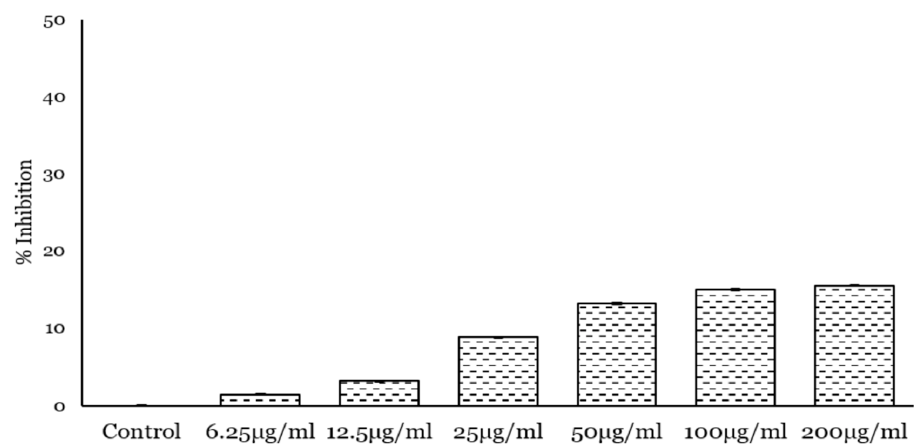
Figure 5. Cytotoxicity effect on MDA MB231 cells treated with PcOSM for 72 h measured by MTT assay. Results are reported as percentage of cell death. The bar shows mean ± Standard deviation of triplicates. Statistical significance of the treated and untreated cells were analyzed using one way ANNOVA. PcOSM treated cells were significantly different from control cells ( p < 0.001).